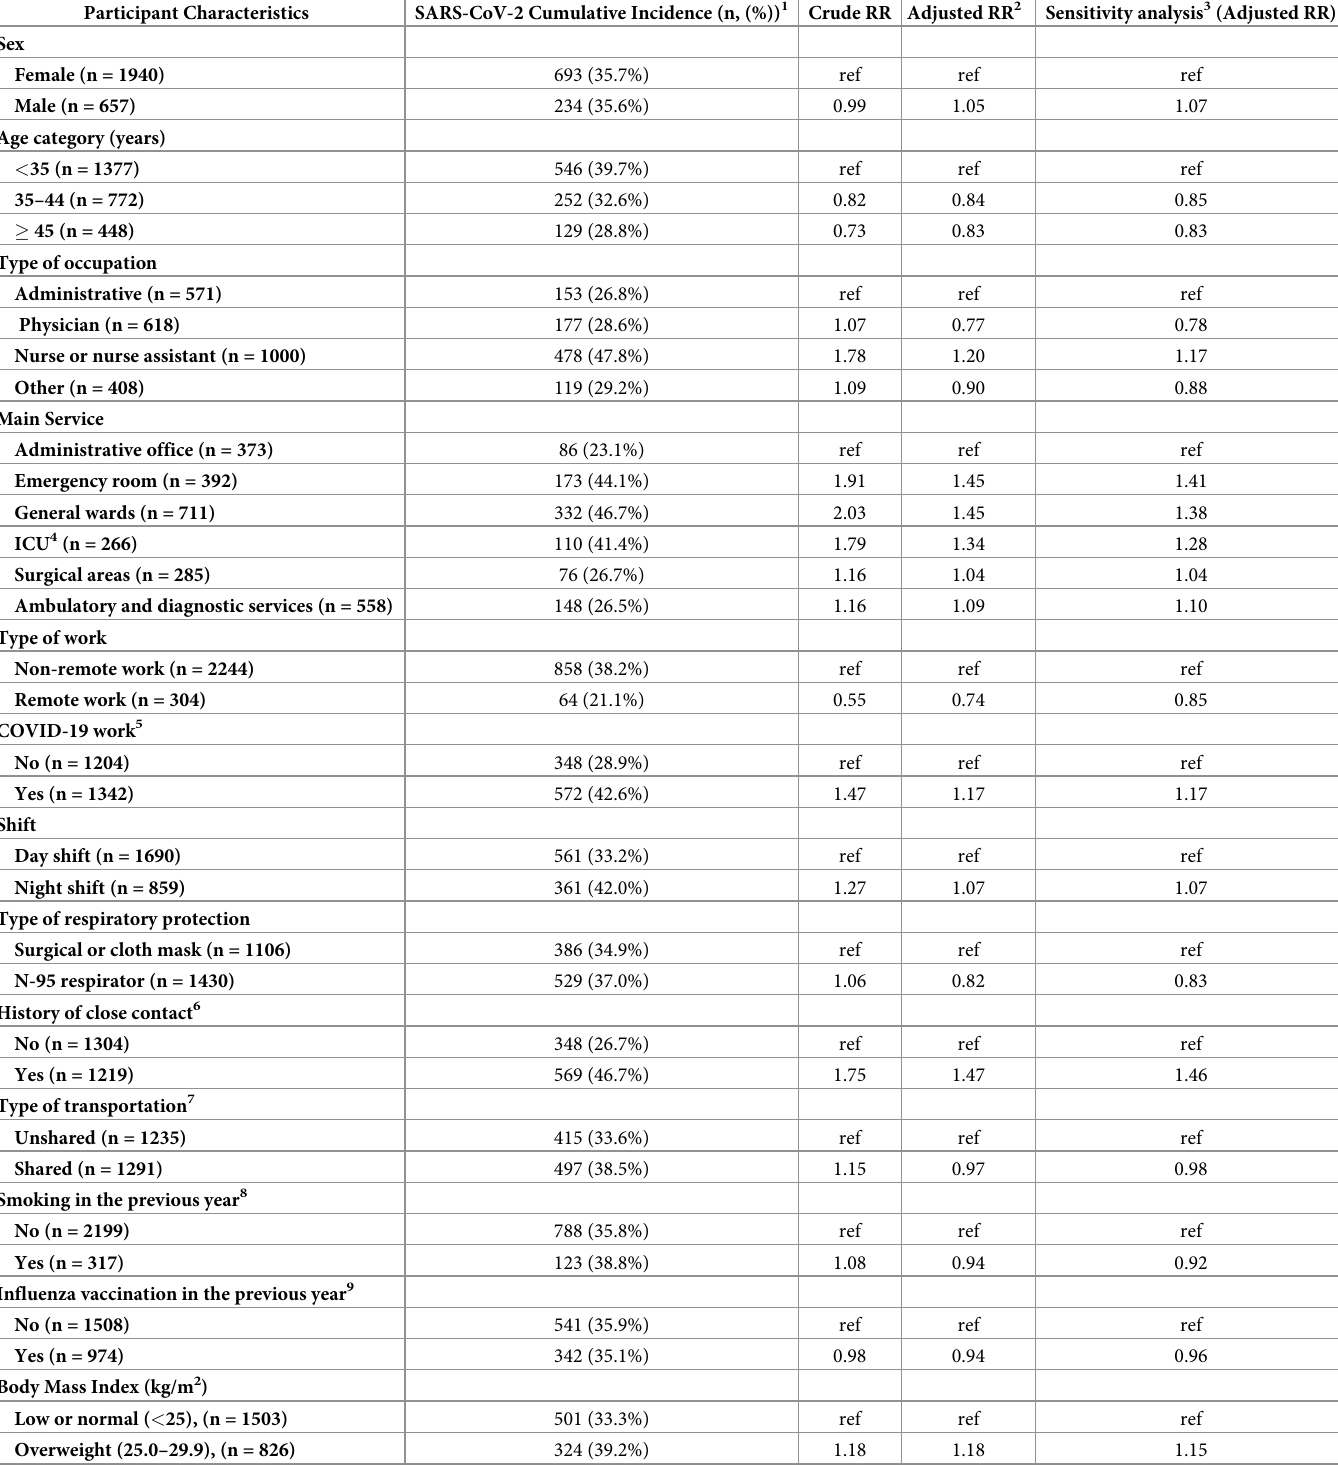
Table 3. Association between sociodemographic, clinical, and occupational characteristics and SARS-CoV-2 infection in HCWs at Hospital Universitario San Igna- cio from March 6, 2020, to February 12, 2021. Participant